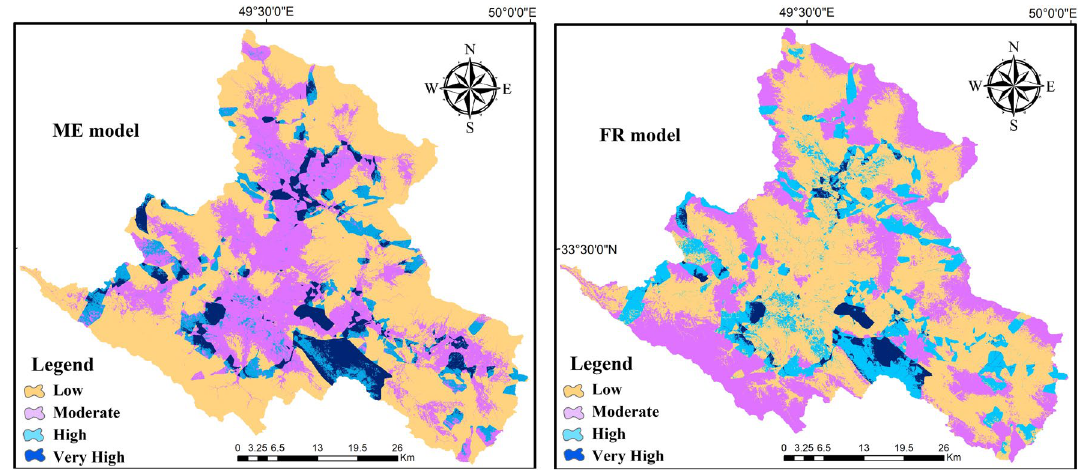
Figure 8. GWR potential zone map, (a) ME model and (b) FR model (maps layouts were prepared in ArcGIS 10.6 software).